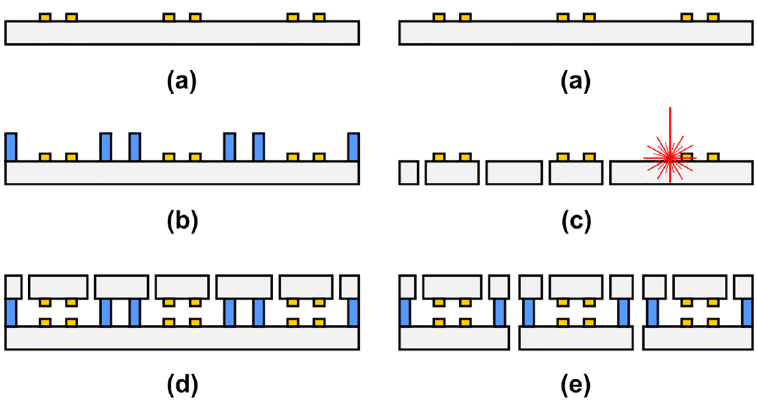
Fig 5. Fabrication steps of the double Lenz lens chips. (a) Au-electroplating of lenses on two glass substrates. (b) Lamination and structuring of dry film photoresist on first wafer. (c) UV-laser drillingof microfluidic ports into second wafer. (d) Adhesivefull-wafer bondingof both substrates. (e) Dicing of individual